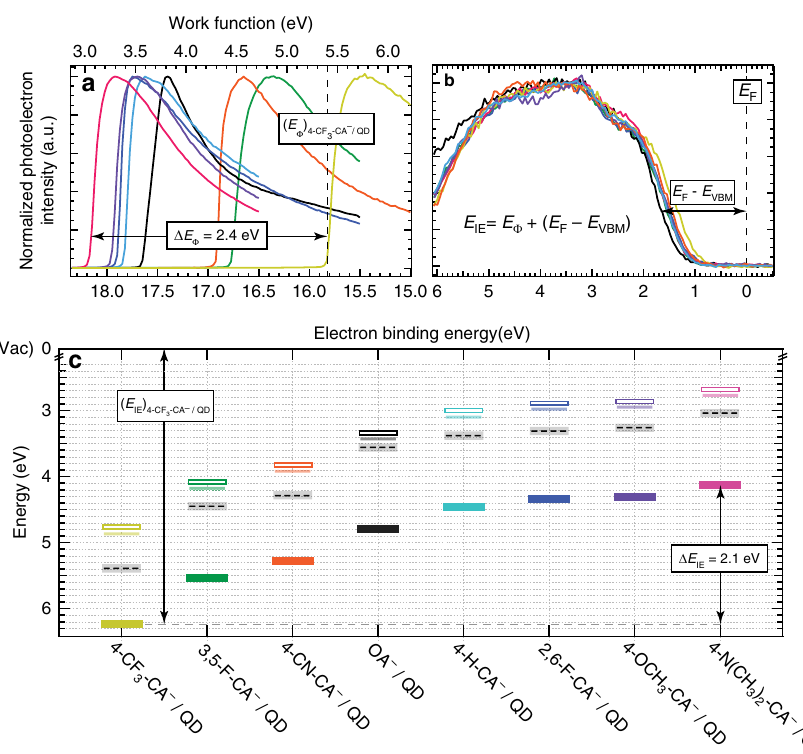
Figure 3 | Photoelectron spectroscopy measurements of ligand/QD complexes. ( a ) Secondary electron cut-off region of XPS spectra used to determine ligand/QD film work function. ( b ) Valence band edge region of XPS spectra used to extract the ligand/QD film VBM with respect to the Fermi energy ( E F (cid:2) E VBM ). The VBM energies were extracted as described in Supplementary Note 3. The dashed black line represents the instrument equilibrated Fermi energy at an electron binding energy of 0eV. ( c ) Band edge energies of films fabricated from OA (cid:2) and R-CA (cid:2) terminated 3.2nm diameter PbS QDs; ionization energy (solid rectangles) and work function (dashed black lines). We also include the conduction band minimum ( E CBM , open rectangles) that is determined from summing the optical gap determined from absorbance measurements (opaque lines) and calculated exciton binding energy. The variation in the measurements made for duplicate samples was lower than the instrumental noise; therefore, the uncertainty of the ionization energy and work function values are represented as the vertical height of the closed rectangle and surrounding light gray rectangle, Table 2), once normalized for ligand stoichiometry, remains nominally constant between the OA (cid:2) /QDs and R-CA (cid:2) /QDs indicating the ligand-to-QD ratio remains constant. Next we considered that, in the calculations, the ligands are oriented mostly perpendicular to the QD surface, while experimental configurations may vary, for example, due to steric or cooperative packing at the surface. However, all three of our models with